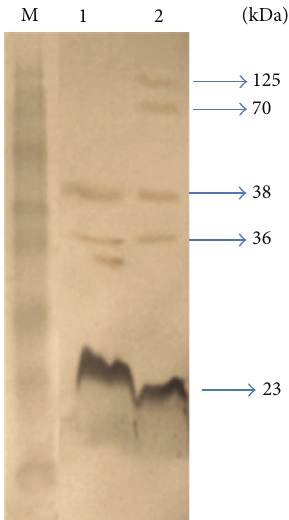
Figure 2: Immunodominant outer membrane proteins of Pas- teurellamultocida B:2inhyperimmunesera.LaneM:proteinmarker (170–15kDa). Lane 1: immunodominant protein in normal condi- tion. Lane 2: immunodominant proteins in iron-limited condition.